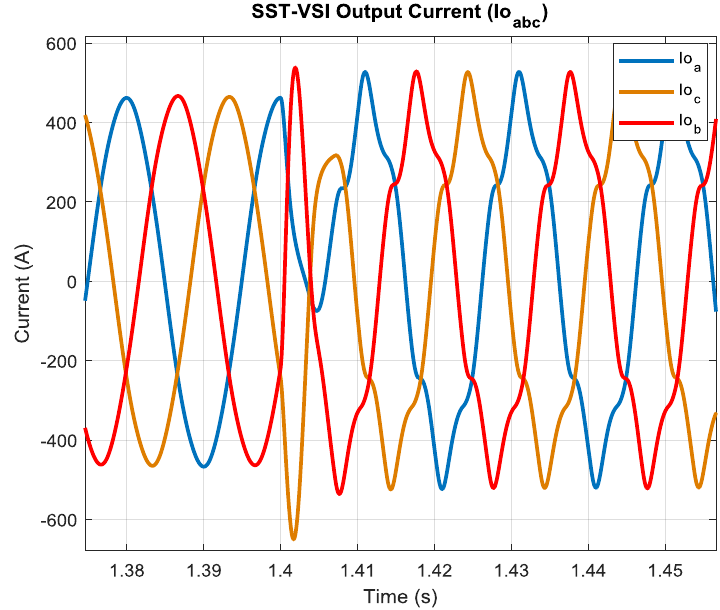
Figure 29. SST output current to the load. The figure is displaying the shift in current from the inductive load to the capacitive load at 1.4 s.